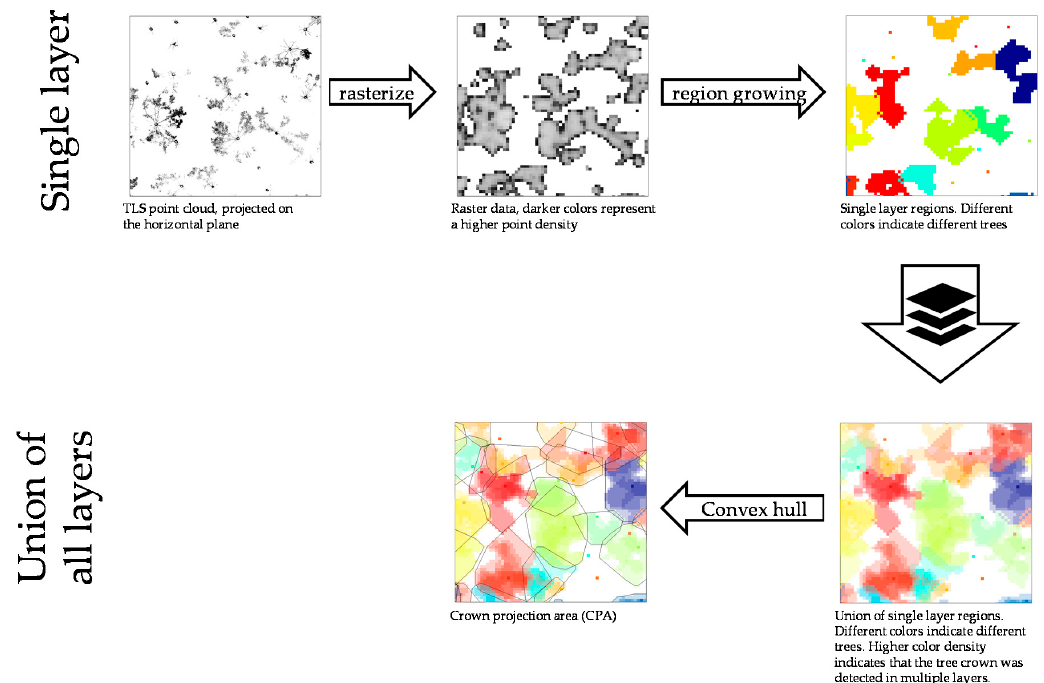
Figure 1. Flowchart of the multi-layer seeded region growing procedure. The top-row shows the procedure for a single layer, and the bottom row shows the procedure for the union of all layers. The depicted tile size is 20 m × 20 m.